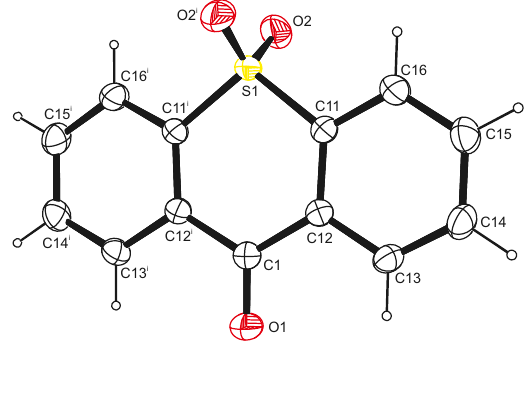
Table  : Data collection and